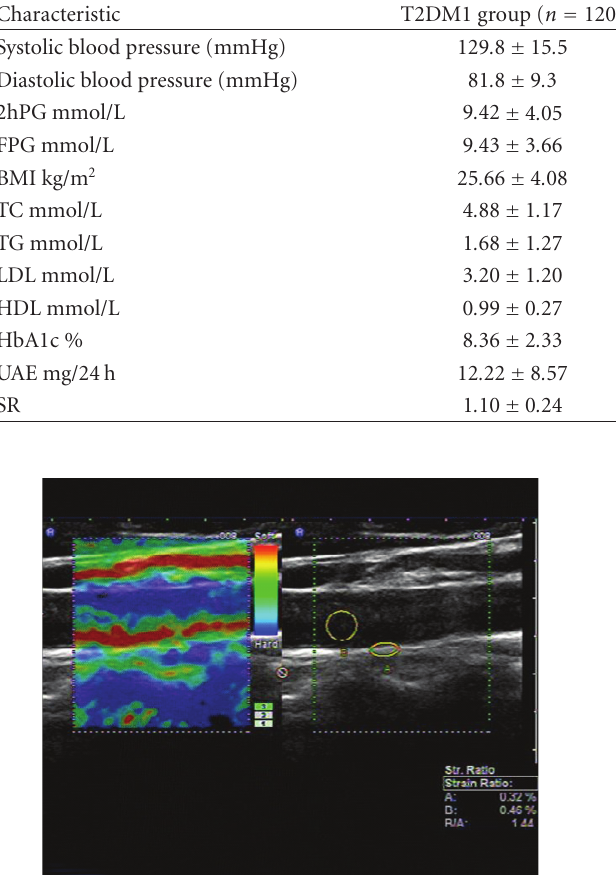
Figure 2: Longitudinal carotid artery image obtained in T2DM2 group on real-time US elastography. The left image shows the elastographic image in di ff erent colors representing di ff erent levels of strain. The right image shows the positions of ROI (A) and ROI (B), and the strain ratio (blood to carotid arterial wall strain ratio) as 2.40, calculated as the blood strain (B, 0.44%) divided by the arterial wall strain (A,